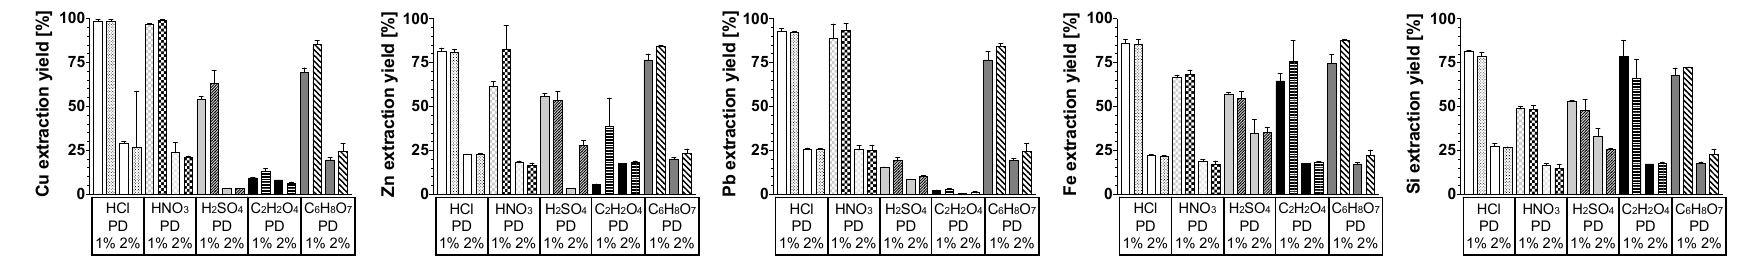
Figure 5. Chemical extraction of metals from amorphous slag treated with normality equivalent (2 N) acids at various pulp densities (1–2%).